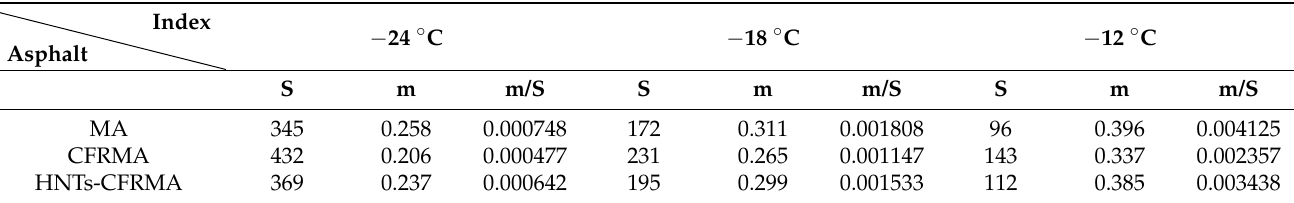
Table 11. Characteristic parameters of asphalt creep at low temperature.